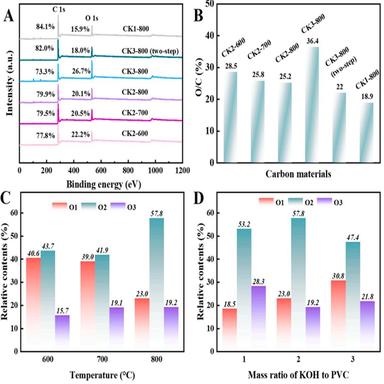
XPS survey of all samples (A), O/C ratios (B), the influence of calcination temperature (C), and KOH dosage (D) on the relative contents of different Ocontaining functional groups in the carbon materials.